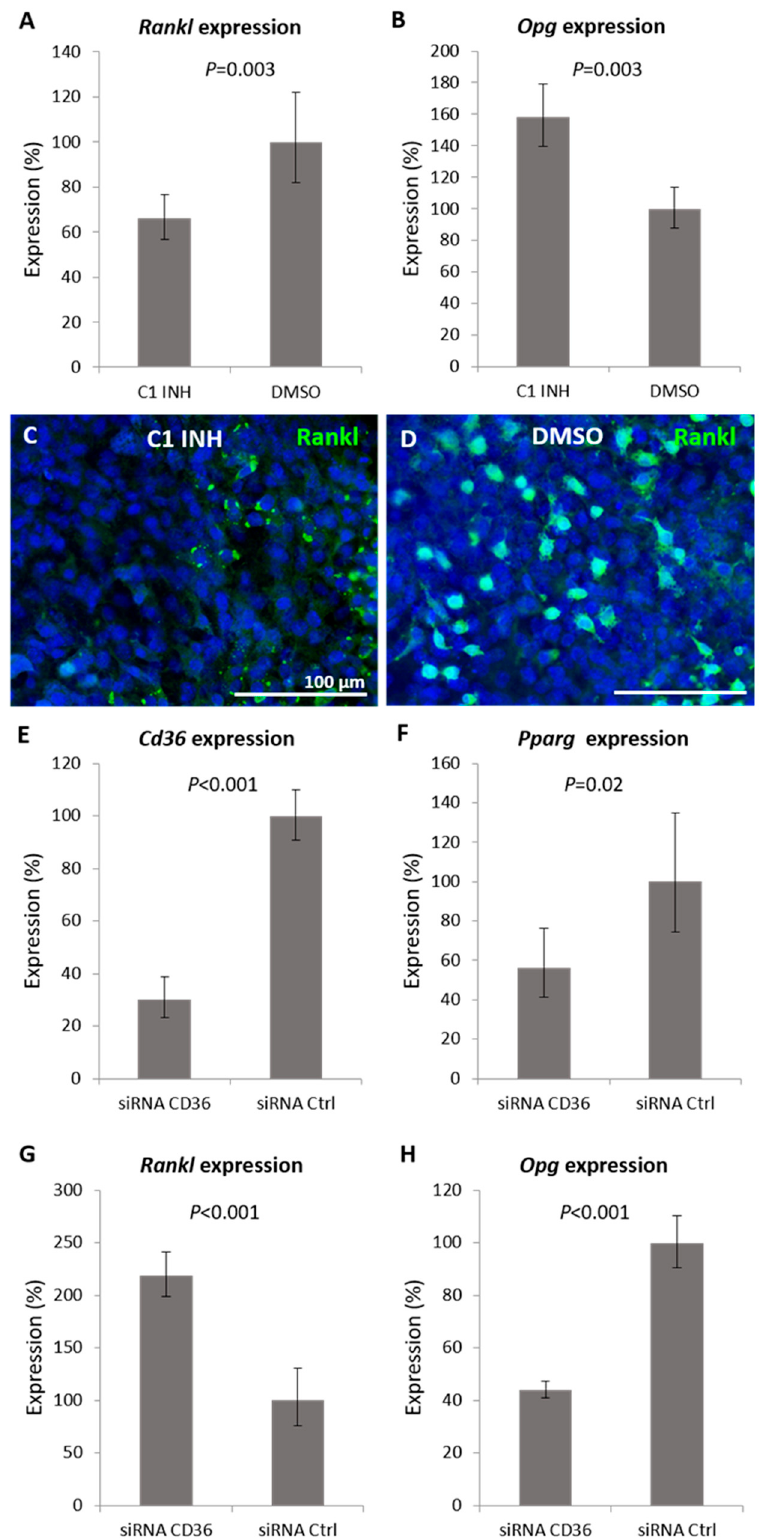
Figure 5. Expression of Rankl and Opg in caspase-1 inhibited or Cd36 silenced micromass cultures. Gene expression of Rankl ( A ) and Opg ( B ) after 6 days of caspase-1 inhibition. Immunofluorescent detection of Rankl (green) in micromass cultures after 6 days of cultivation with caspase-1 inhibitor ( C ) and in control micromasses ( D ). Expression of Cd36 ( E ), Pparg ( F ), Rankl ( G ), and Opg ( H ) after 6 days of Cd36 silencing in micromass cultures. Scale bar = 100 μ m.